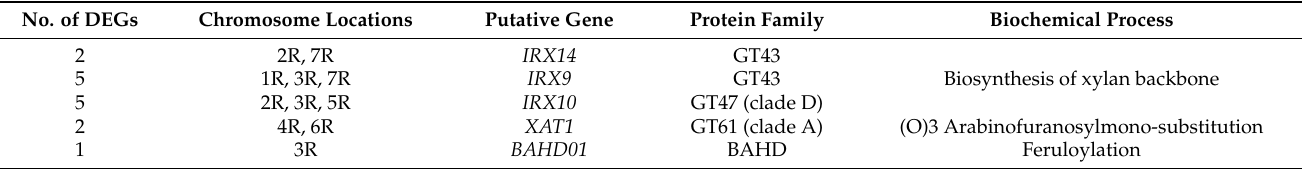
Table 2. Selected summary of the differentially expressed genes (DEGs), which are proposed as rye candidate genes for arabinoxylan biosynthesis in the work of Kozlova et al. [73] (please refer to the original publication for the full lists). Expression of these candidates was the highest at milk stage, and then declined at dough stage and full kernel